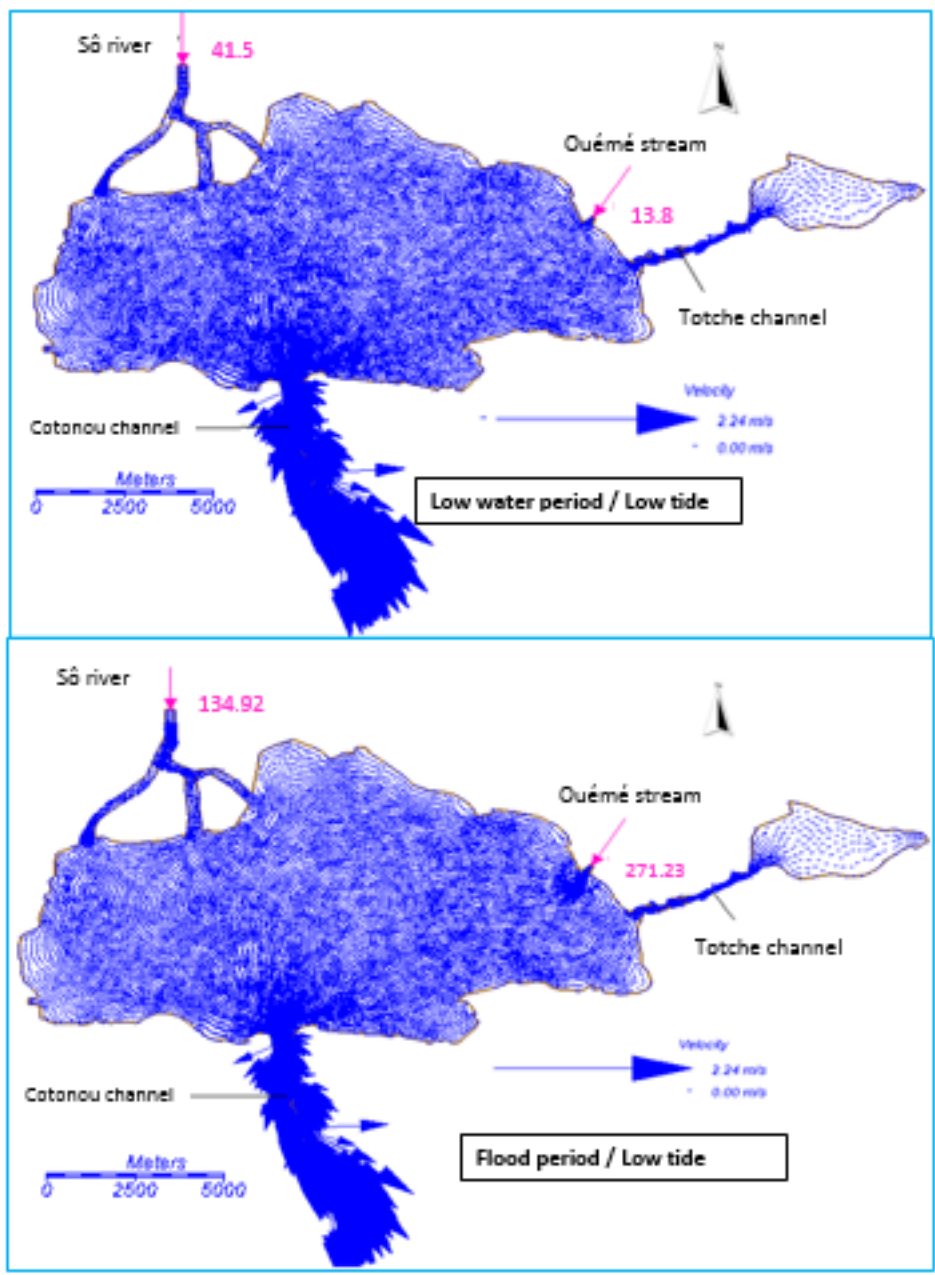
Figure 11. Distribution of velocity field during the emptying of the lake in flood and low water period.